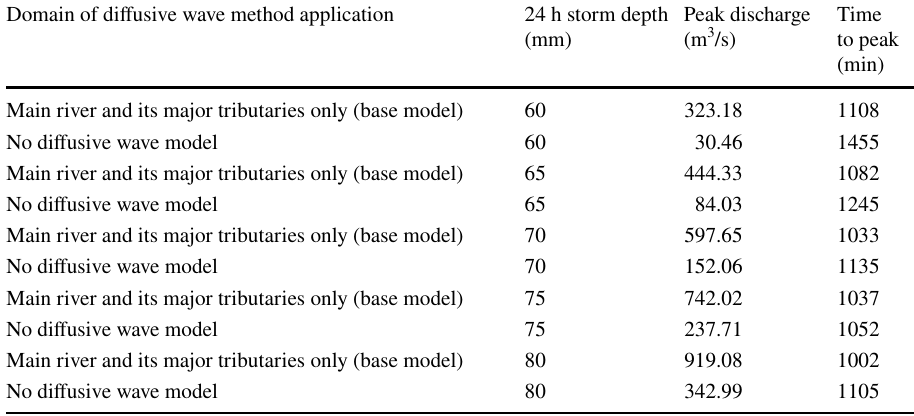
Domain of diffusive wave method